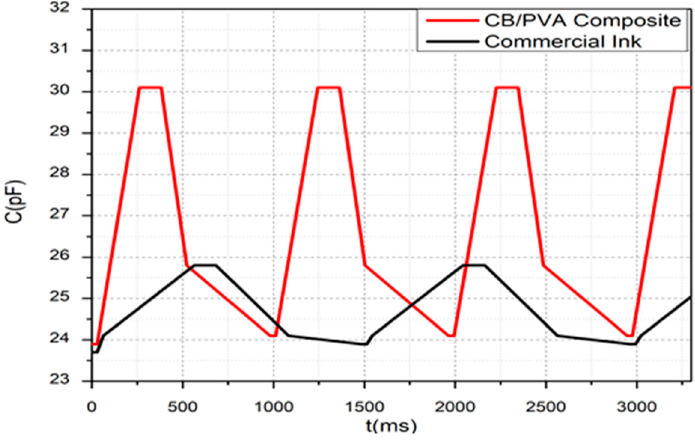
Figure 11. The capacitance-time characteristic under a specific load.